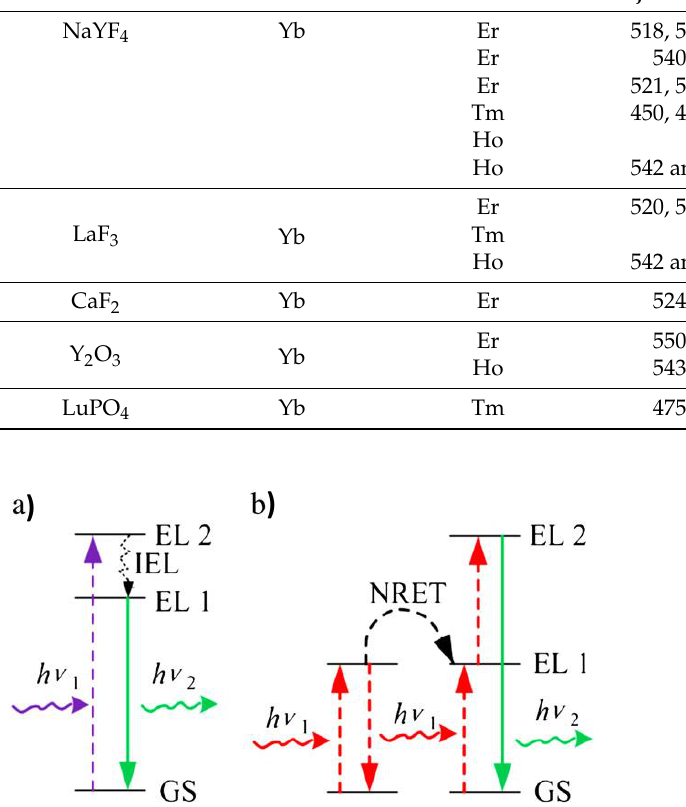
Table 6. Optical characteristics of representative UCNPs Host Lattice